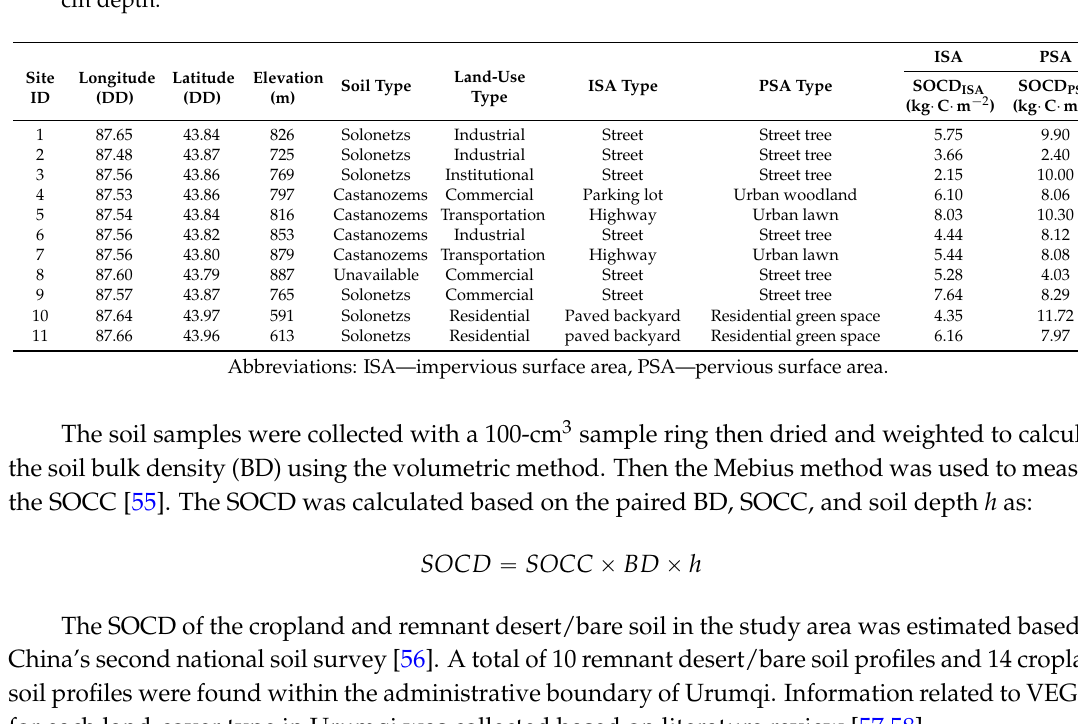
Table 3. Description of the sampling sites, and the observed BD and SOC in the ISA and PSA at 0–80 cm depth.